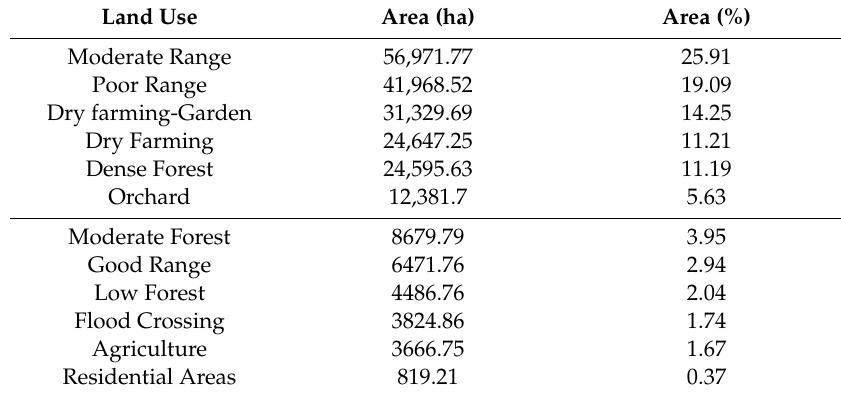
Table 1. Land use classes in the study area.